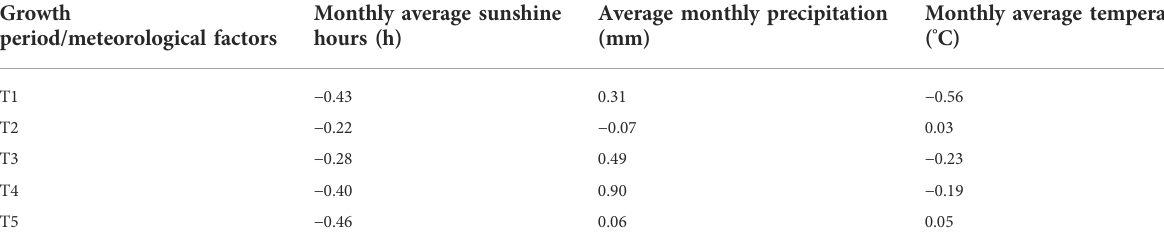
TABLE 3 Correlation between yield reduction rate and meteorological factors in each growing period.